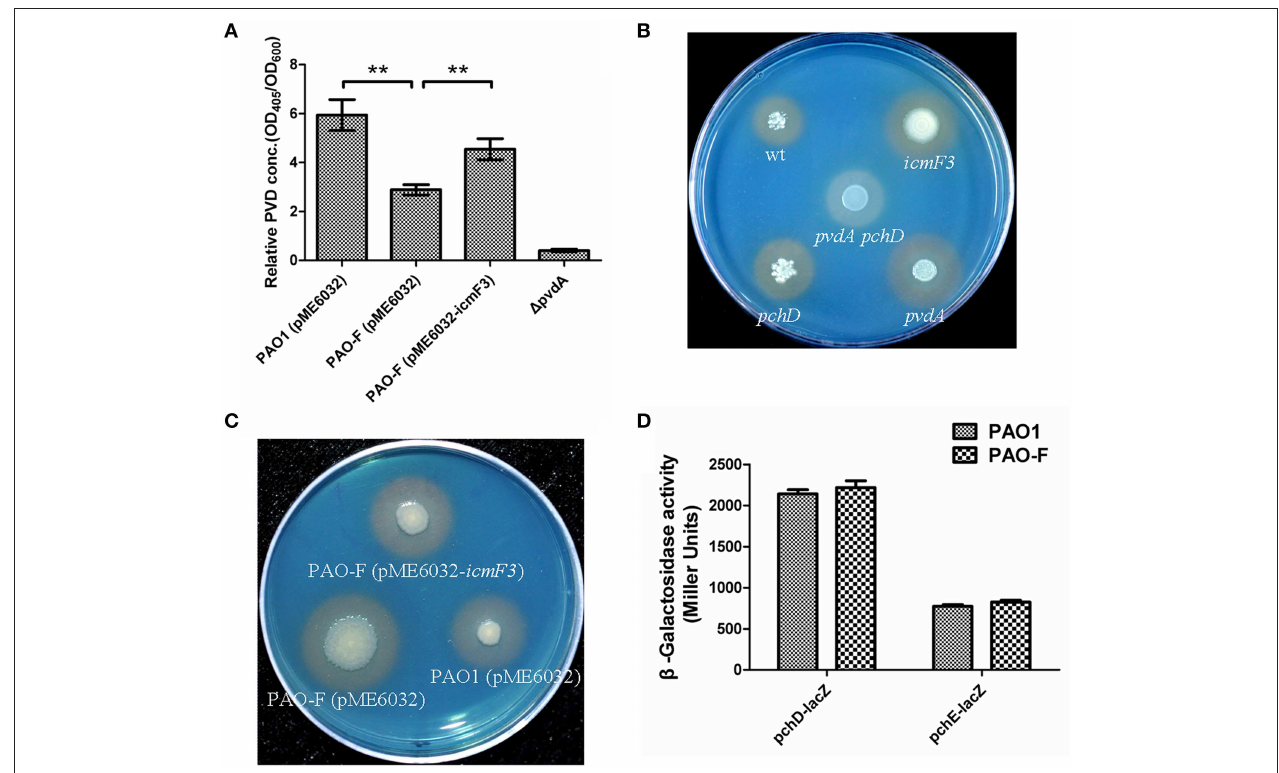
FIGURE 5 | Deletion of icmF3 affects siderophore production. Wild-type and mutant strains were grown at 37 ◦ C in CAA to stationary phase. (A) Relative levels of extracellular pyoverdine (PVD) in culture supernatants were determined spectrophotometrically. Values are presented as the mean (SD) of five independent assays. The 1 pvdA strain was used as a negative control. ** P < 0.01 . (B) Comparison of the colored halos around wild-type (top left), pchD pyochelin-negative mutant (bottom left), a pyoverdine-negative pvdA mutant (bottom right), a double pvdApchD mutant (center), and the icmF3 mutant (top right) colonies. (C) Comparison of the colored halos around PAO1 (pME6032) (bottom right), PAO-F (pME6032) (bottom left), PAO-F (pME6032- icmF3 ) (top) colonies. (D) Cells were cultured in CAA and levels of pchDCBA and pchEFGHI transcription in P. aeruginosa PAO1 and icmF3 mutant cells were monitored using the pchD–lacZ and pchE–lacZ transcriptional fusions, respectively. If needed, 1mM IPTG was included in the medium for induction. The graphs show the mean and SD of two experiments performed in eight replicates each